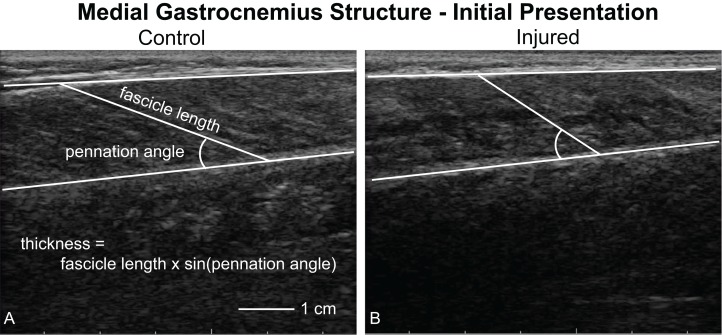
Ultrasound imaging quantifying muscle structure.Ultrasound images of the medial gastrocnemius were acquired and analyzed by the same investigator to quantify resting fascicle length, pennation angle, thickness, and muscle belly echogenicity. This figure shows a representative image of both the uninjured (A, control) and injured (B) sides. Fascicle length and pennation angle was analyzed by the same observer for all trials. Muscle thickness was calculated as the product of the fascicle length and sine of the pennation angle. During our initial analyses, we noticed that the injured limb displayed “poor quality” muscle, as noted by a lack of contrast between the fascicles and interstitial connective tissue.